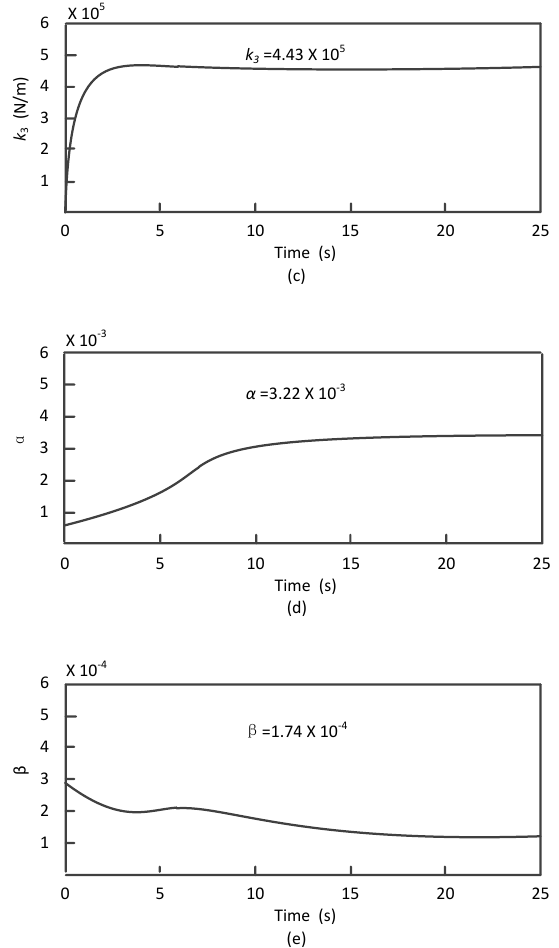
Figure 5. Identification results of the system parameters under the nondestructive working conditions: ( a ) recognition results of k 1 , ( b ) recognition results of k 2 , ( c ) recognition results of k 3 , ( d ) recognition results of α and ( e ) recognition results of β .